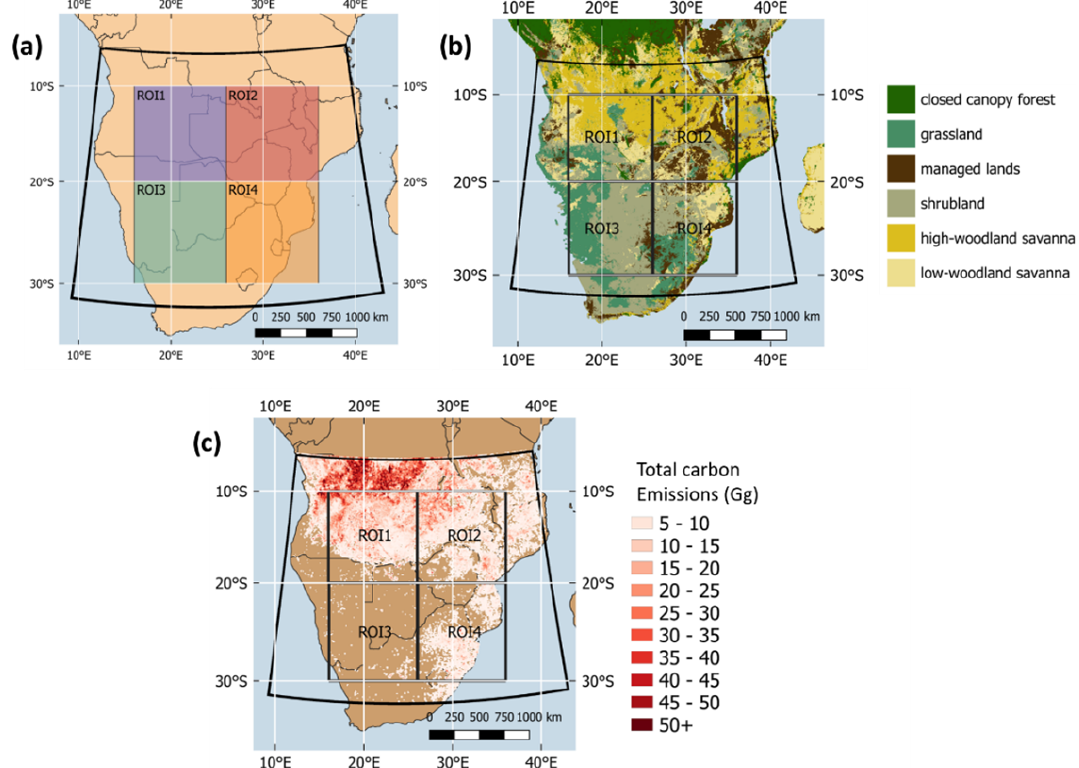
Figure 8. Southern Hemisphere Africa (SHAF) model domain in WRF-CMAQ, fed with the FREM-derived landscape fire CO emissions inventory developed herein. Boxes indicate four smaller regions of interest (ROIs) used in comparisons of model output to satellite-derived CO observations. (a) Domain and ROIs, (b) spatial distribution of the six fire-affected biomes defined herein, and (c) spatial distribution of fire-emitted total carbon released between 15 July and 29 August as estimated from the FREMs_bCO emissions inventory, calculated through the application of Eq. (1) to obtain DMC and then carbon fraction. This FREMs_bCO inventory is used as input to the CMAQ